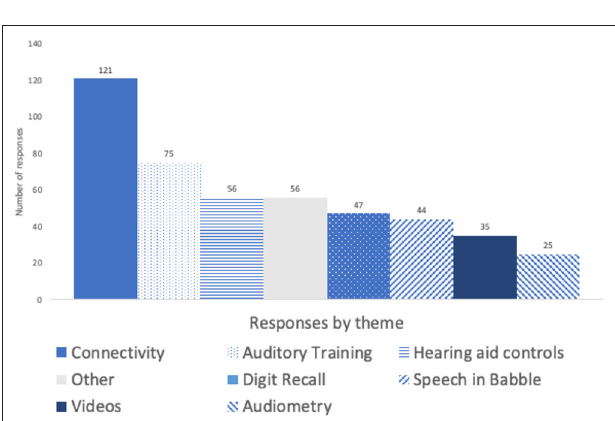
FIGURE 5 | Free text comments volume (number of comments) grouped by